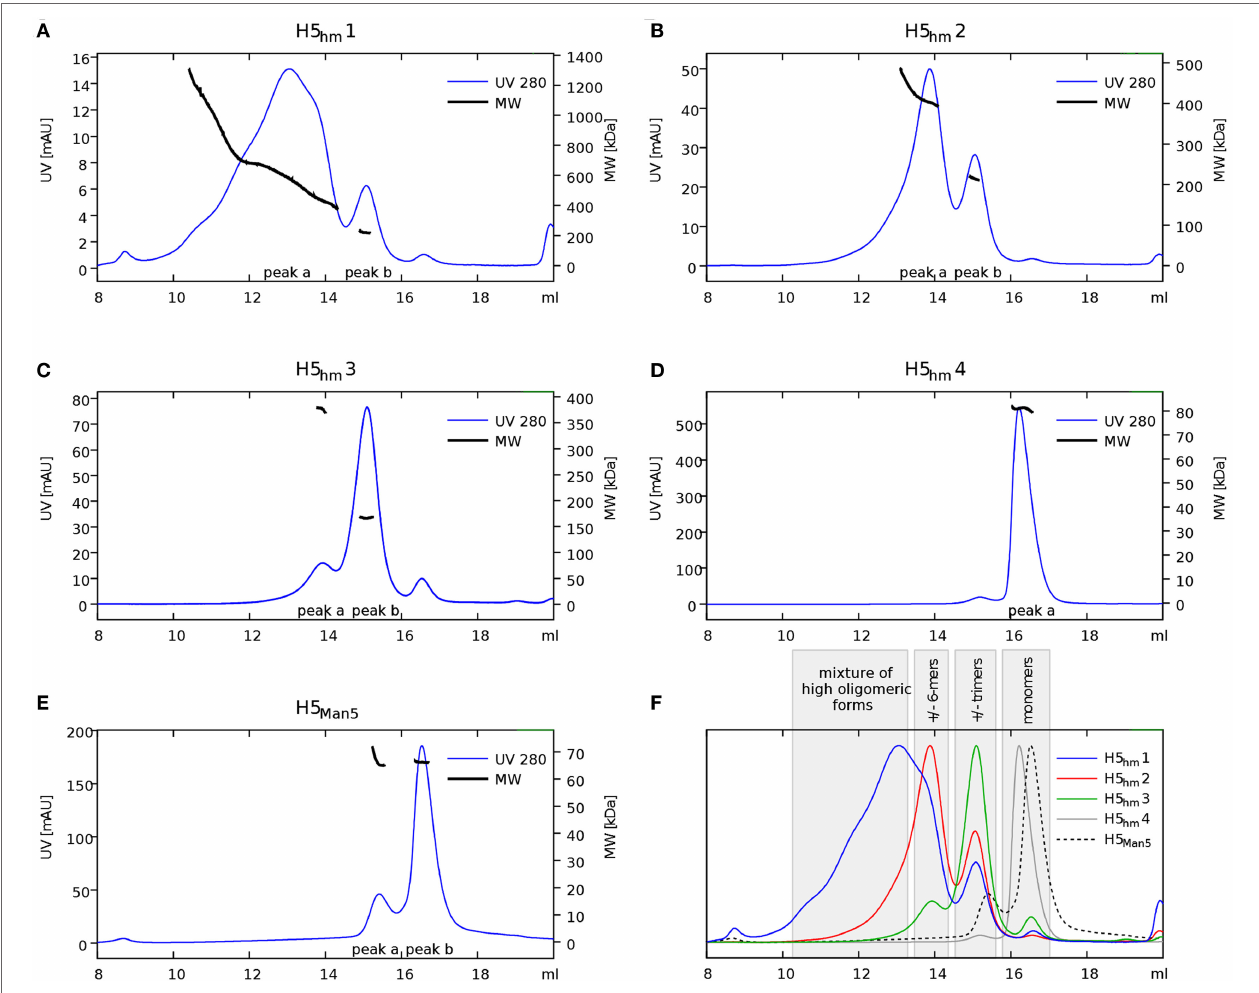
FigUre 4 | size exclusion chromatography (sec)–multi-angle light scattering (Mals) analysis of h5 oligomers . Chromatograms of H5hm (a–D) and H5Man5 (e) oligomers. Different indexes of H5hm samples (1 − 4) correspond to different oligomeric forms depicted in Figure 2 . Molecular weights (MWs), measured by MALS, are indicated by black line. Theoretical MW value for H5 monomer is 57.8 kDa. Measured MW are higher than theoretical due to the glycosylation status of H5 antigens. All corresponding weight-averaged MWs are listed in Table 1 . Overlaid chromatograms with theoretical stoichiometry predicted based on SEC–MALS results are depicted in panel (F) .